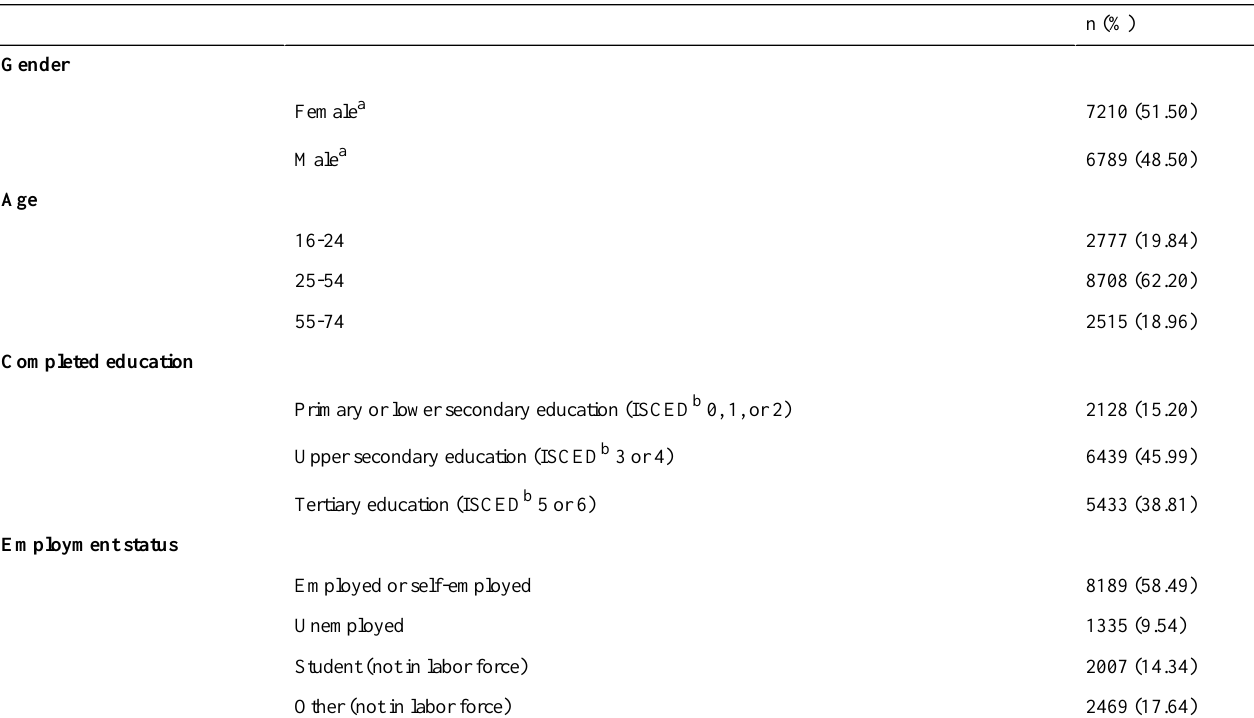
Table 2. Sample sociodemographic characteristics